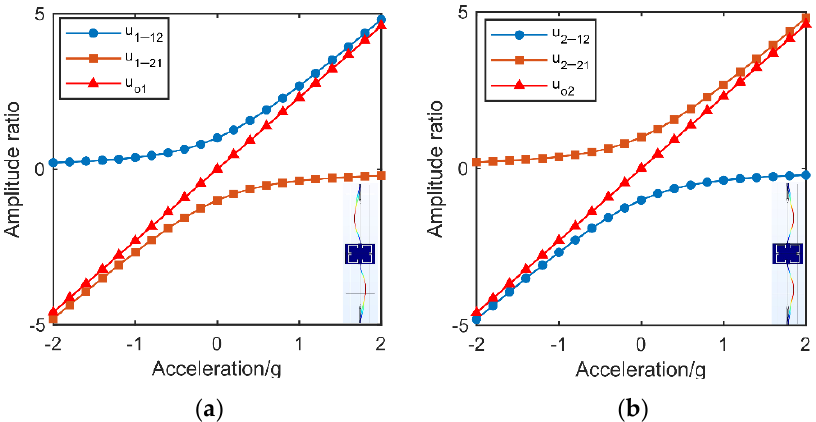
Figure 3. ( a ) Mode shape, amplitude ratios and linearity-enhanced output metric of the first mode. ( b ) Mode shape, amplitude ratios and linearity-enhanced output metric of the second mode.